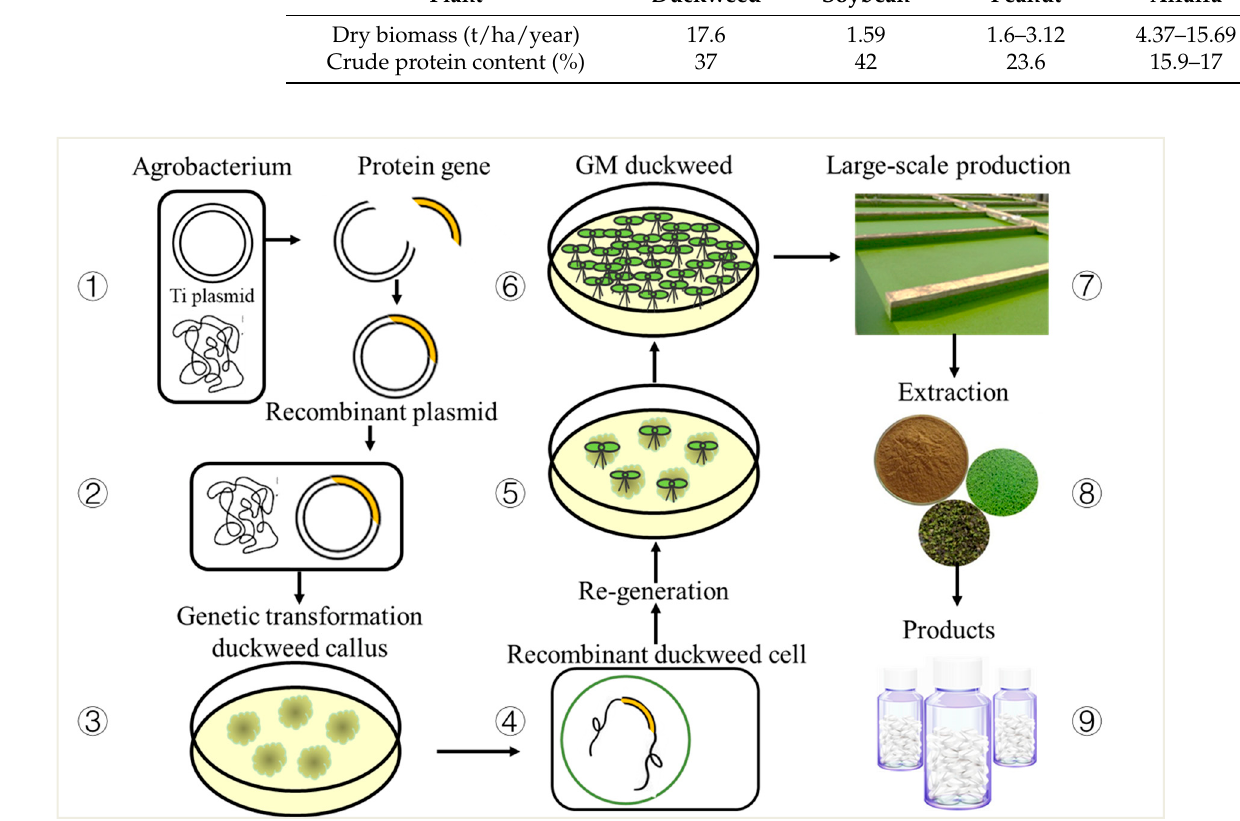
Figure 3. Duckweed platform. The schematic diagram shows the general process of using duckweed as a target products expression platform ： ① Clone the target gene and integrate it to obtain a recombinant plasmid. ② Transform the recombinant plasmid into a suitable Agrobacterium tumefacien . ③ Co-culture the recombinant Agrobacterium tumefacien with duckweed callus. ④ Obtain recombinant duckweed cells using a selective medium. ⑤ Induce recombinant duckweed cells to regenerate frond. ⑥ Identify and reproduce stable and genetically modified duckweed. ⑦ Apply the stable and uniform transgenic duckweed for large-scale production. ⑧ Extract the target protein after cultivation to obtain biomass. ⑨ Purify the target protein and process it for product development. Table 3. Comparison of protein yield between duckweed and high-protein crops [51].